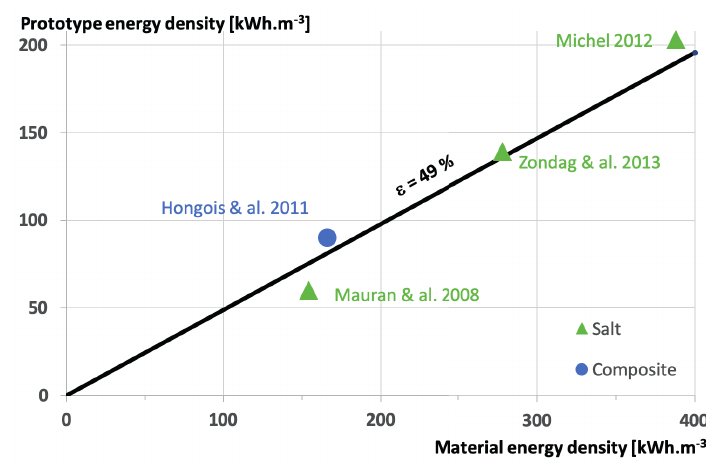
Figure 6. Prototype energy density versus material energy